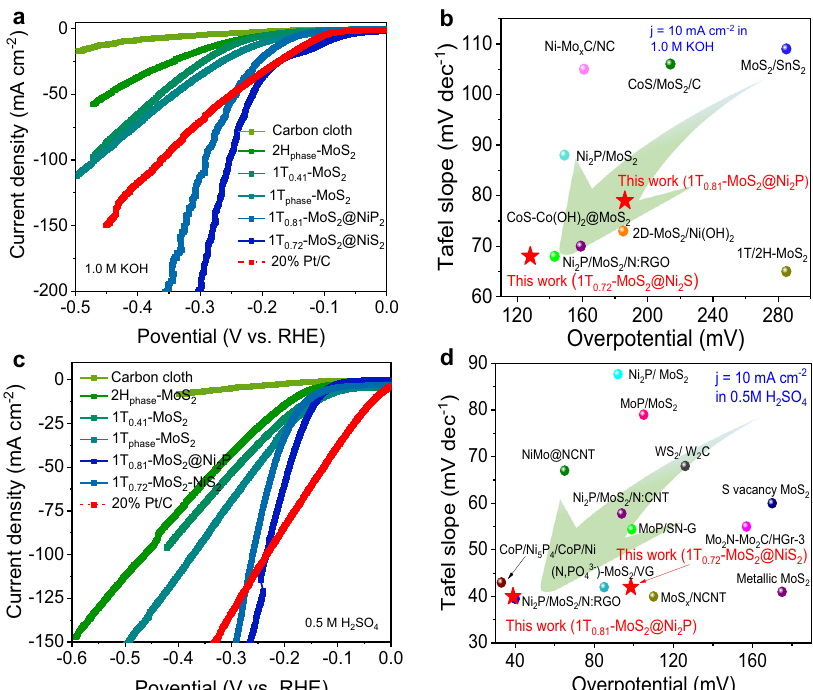
Fig. 3 HER was performed in alkaline and acidic electrolytes. a LSV curves in 1 M KOH. b η 10 and Tafel slopes for various Mo-based HER electrocatalysts in 1.0 M KOH. c LSV curves in 0.5 M H 2 SO 4 . d η 10 and Tafel slopes for various Mo-based HER catalysts in 0.5 M H 2 SO 4 . (All LSV curves were corrected without